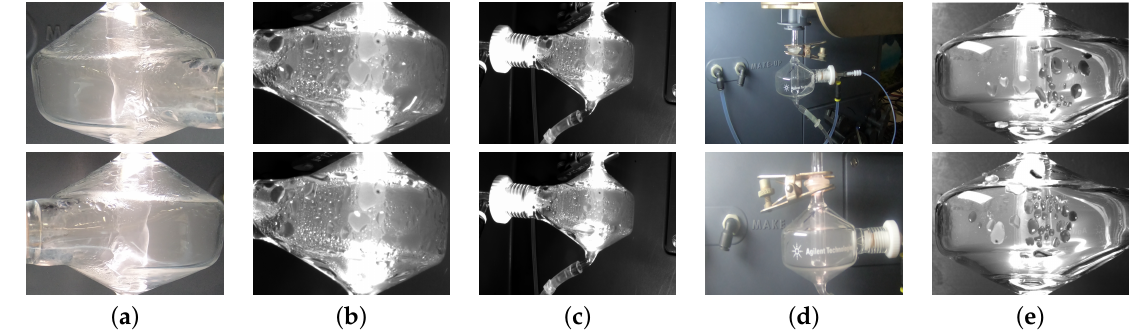
Figure 7. Dataset Types, which are cumulative. ( a ) Type 2, which is cropped of view 2 (GoPro feed). ( b ) Type 3, including cropped of view 3 (Basler feed). ( c ) Type 4, which includes uncropped Basler feed. ( d ) Type 5, which included non-beading, uncropped chambers. ( e ) Type 6, which includes synthetic